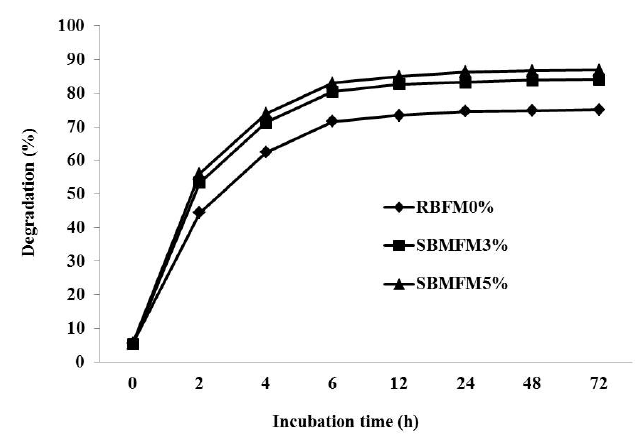
Figure 2. In sacco degradability characteristics of the